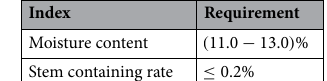
Table 7. Tobacco fragment re-baking index and